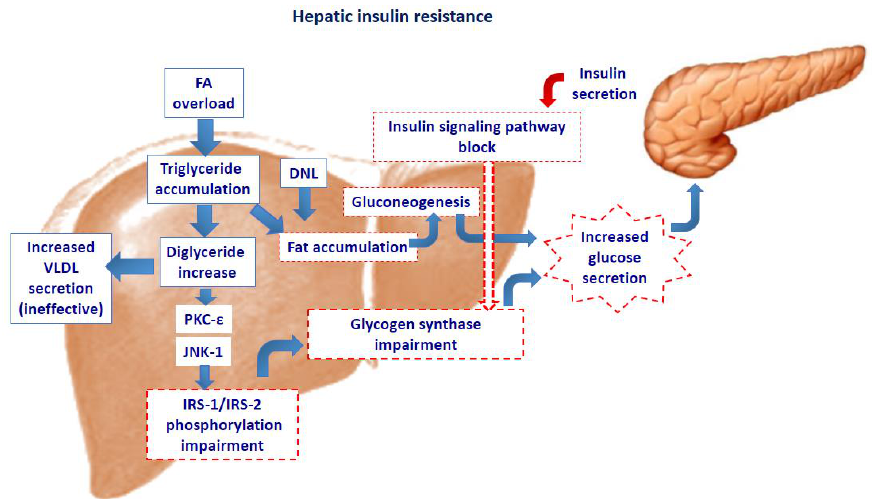
Figure 1. Fatty acid overload in the hepatocyte activates the protein kinase c- epsilon (PKC- ε) and/or c-Jun N-terminal kinase (JNK-1), with subsequent impairment of phosphorylation of the insulin receptor substrate (IRS)-1 and IRS-2. This results in impairment of the insulin signaling pathway. The decreased insulin action on glycogen synthase induces increased glucose secretion. Yet, fat accumulation stimulates neoglucogenesis further increasing the hepatic glucose secretion. The hepatocyte’s attempt to dispose of excessive triglyceride accumulation through increased VLDL secretion, is ineffective, further contributing to accumulation of liver fat. DNL: de novo lipogenesis. In addition to DAG, other lipid species as well as adipose tissue and intrahepatic inflammation and ER stress have been suggested to contribute to insulin resistance [23] (Figure 2).